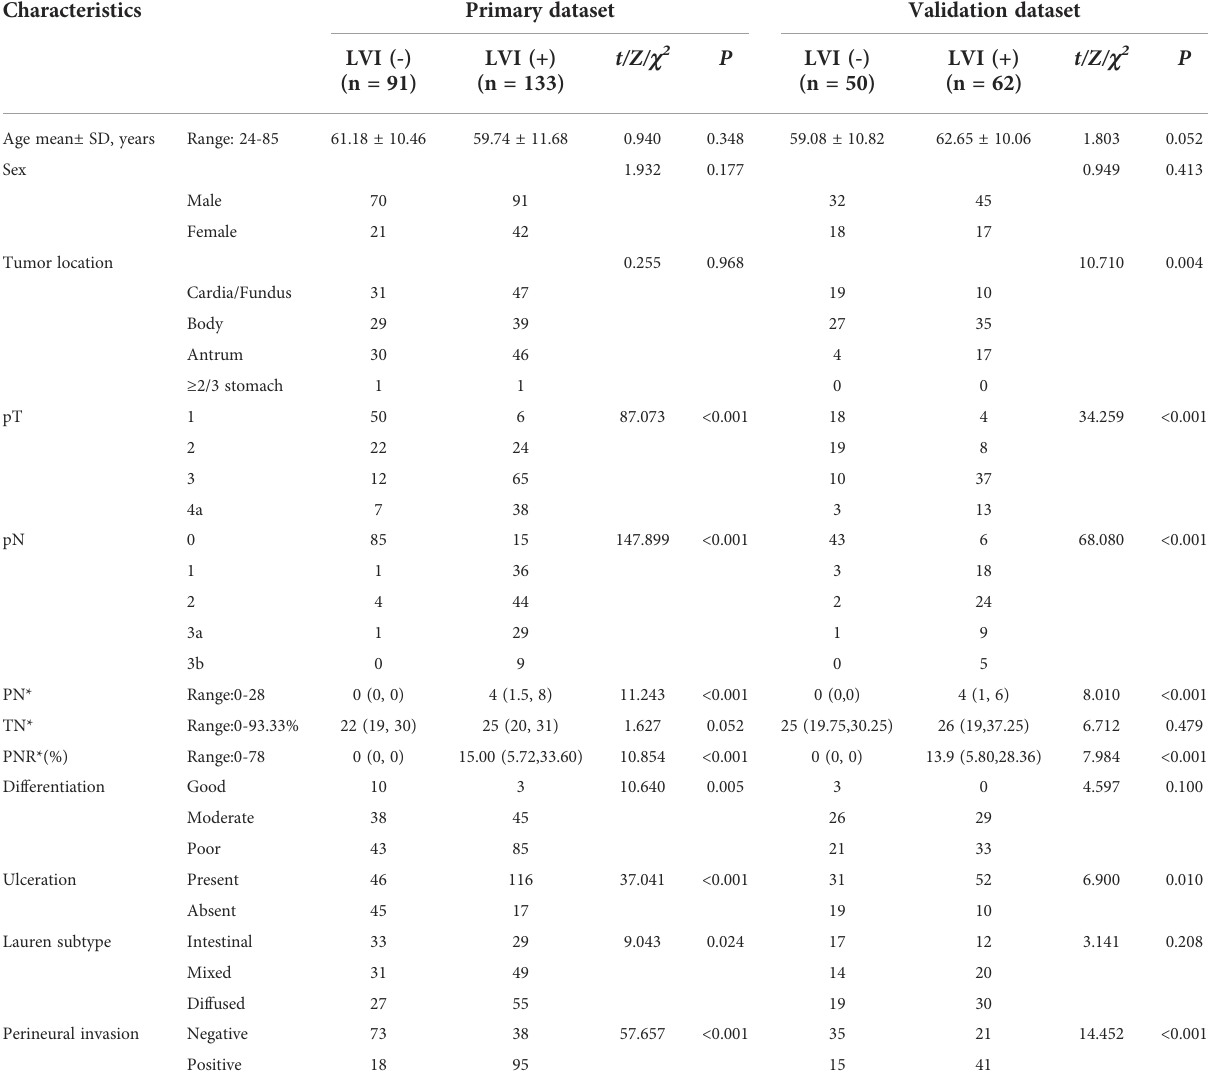
TABLE 2 Comparison of clinicopathological characteristics between LVI positive and LVI negative groups in the primary and validation datasets. Characteristics